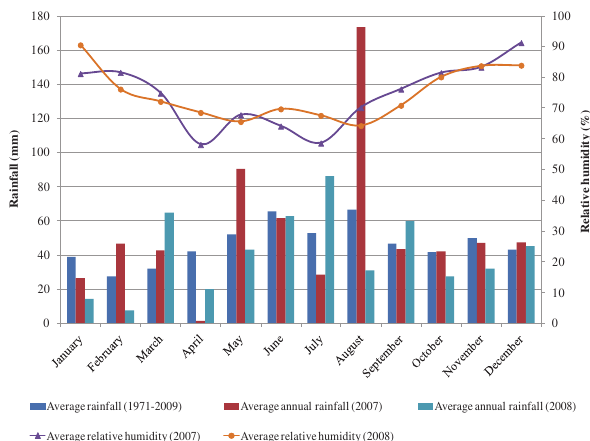
Figure 2. Precipitation and relative humidity in the years of 2007 and